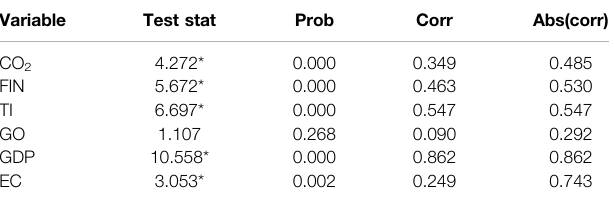
TABLE 2 | Test results of CD. TABLE 3 | slope heterogeneity test results.